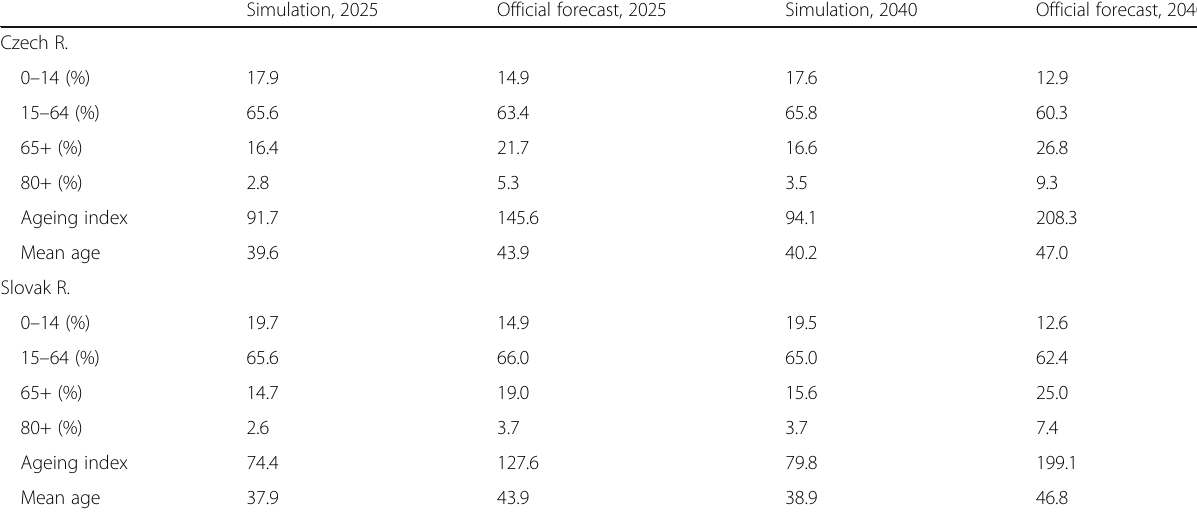
Table 3 Age structure, comparison of the official forecasts and simulation in 2025 and 2040 Simulation, 2025 Official forecast, 2025 Simulation, 2040 Official forecast, 2040 Czech